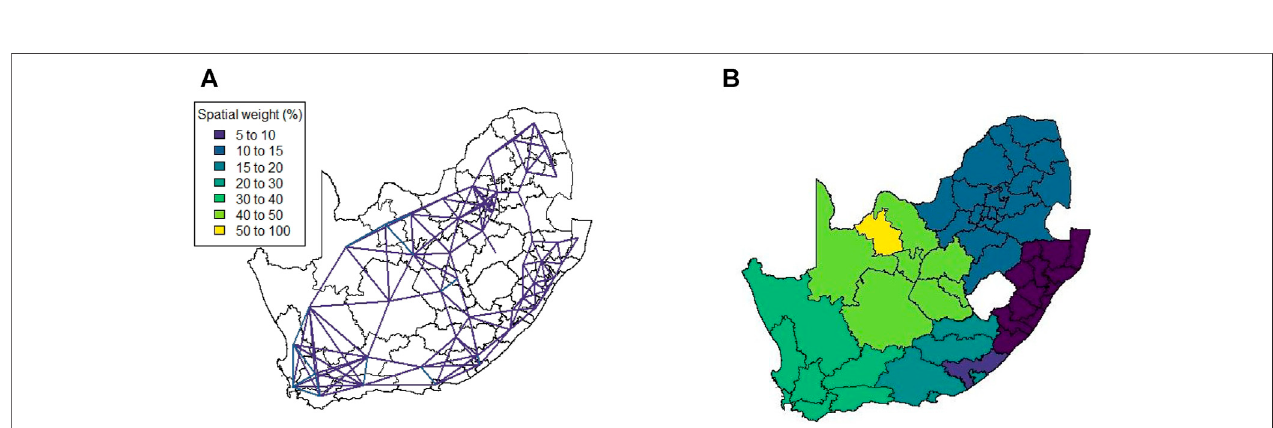
FIGURE 11 | Method 4 (A) Spatial weights (weights ≤ 5 not shown), (B) Complete linkage clustering (7 clusters indicated by colours).